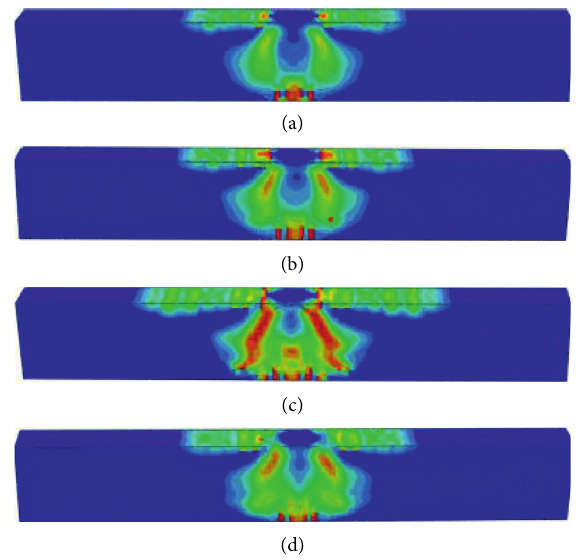
Figure 17: Local tensile damages: (a) L16-3-T, (b) L16-2-T, (c) L16-1-T, (d)